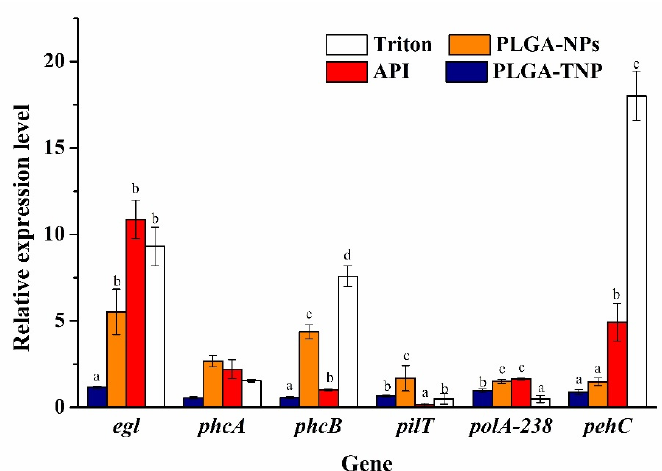
Figure 8. Effect of PLGA-TNPs loaded with MC and CAPE on the virulence-related gene expression of R. solanacearum . Those treatments were designated the PLGA-TNP, PLGA-NP, API, and Triton groups, respectively. The Triton group was used as the blank group. The gene expression levels of egl , phcA , phcB , pilT , polA-238, and pehC were obtained in the R. solanacearum treated with bacteriostatic agents for 24 h. The letters in the columns indicate the differences between the different treatment groups, the same letter indicates that the difference is not significant ( p > 0.05), and completely different letters indicate a significant difference ( p <